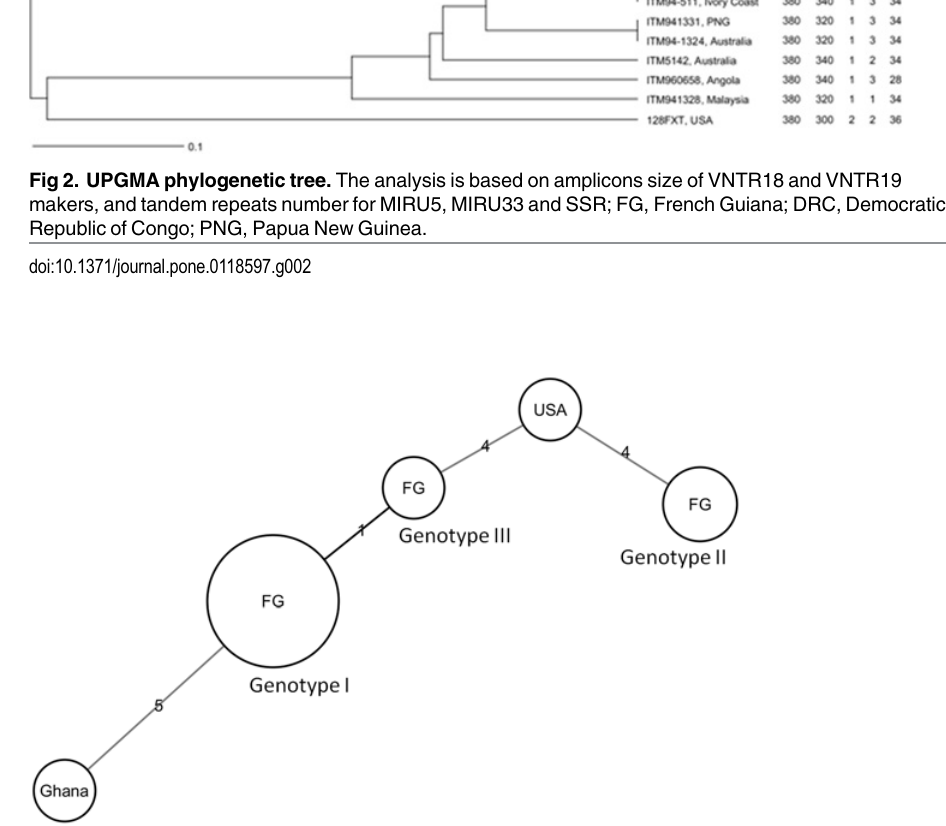
Fig 3. Minimum Spanning Tree. The analysis is based on sequence type for 6 VNTR markers where each circle is a graphical representation of sample size of each genotype (although not strictly proportional); the number of alleles differing between genotypes is indicated on each branch; FG, French